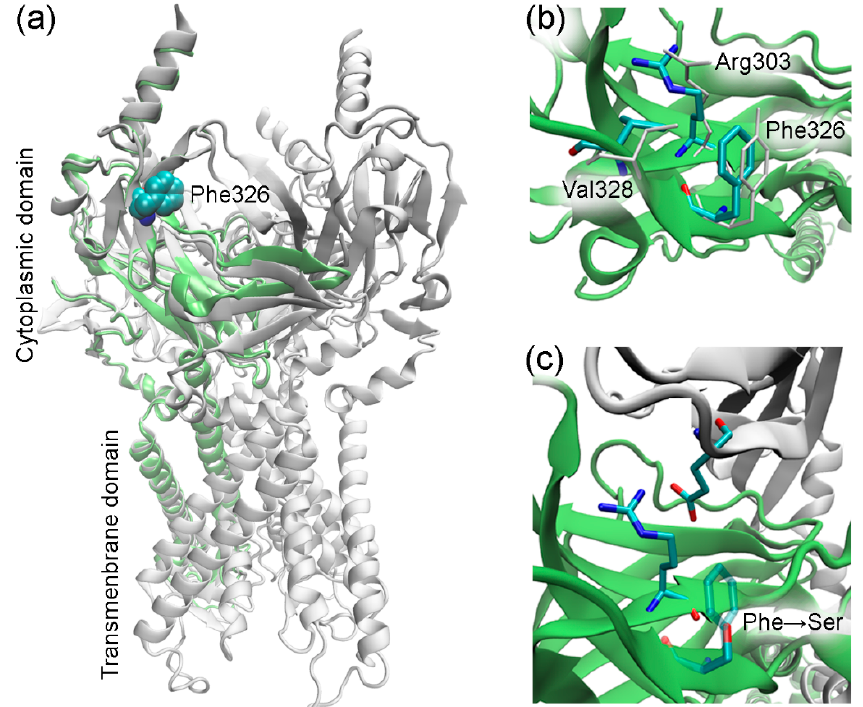
Figure 2. Homology modeling of GIRK3. ( a ) Modeled GIRK3 subunit. The template GIRK2 structure (3sya, tetrameric assembly) is shown in white, and GIRK3 is shown in lime. ( b ) Molecular environment of the residue 326 in GIRK3 (colored by atom type) and GIRK2 (white). ( c ) Phe326Ser substitution in GIRK3. The GIRK2 subunit (3sya) comprising the glutamate residue is shown in white. The figure was prepared using VMD [29].